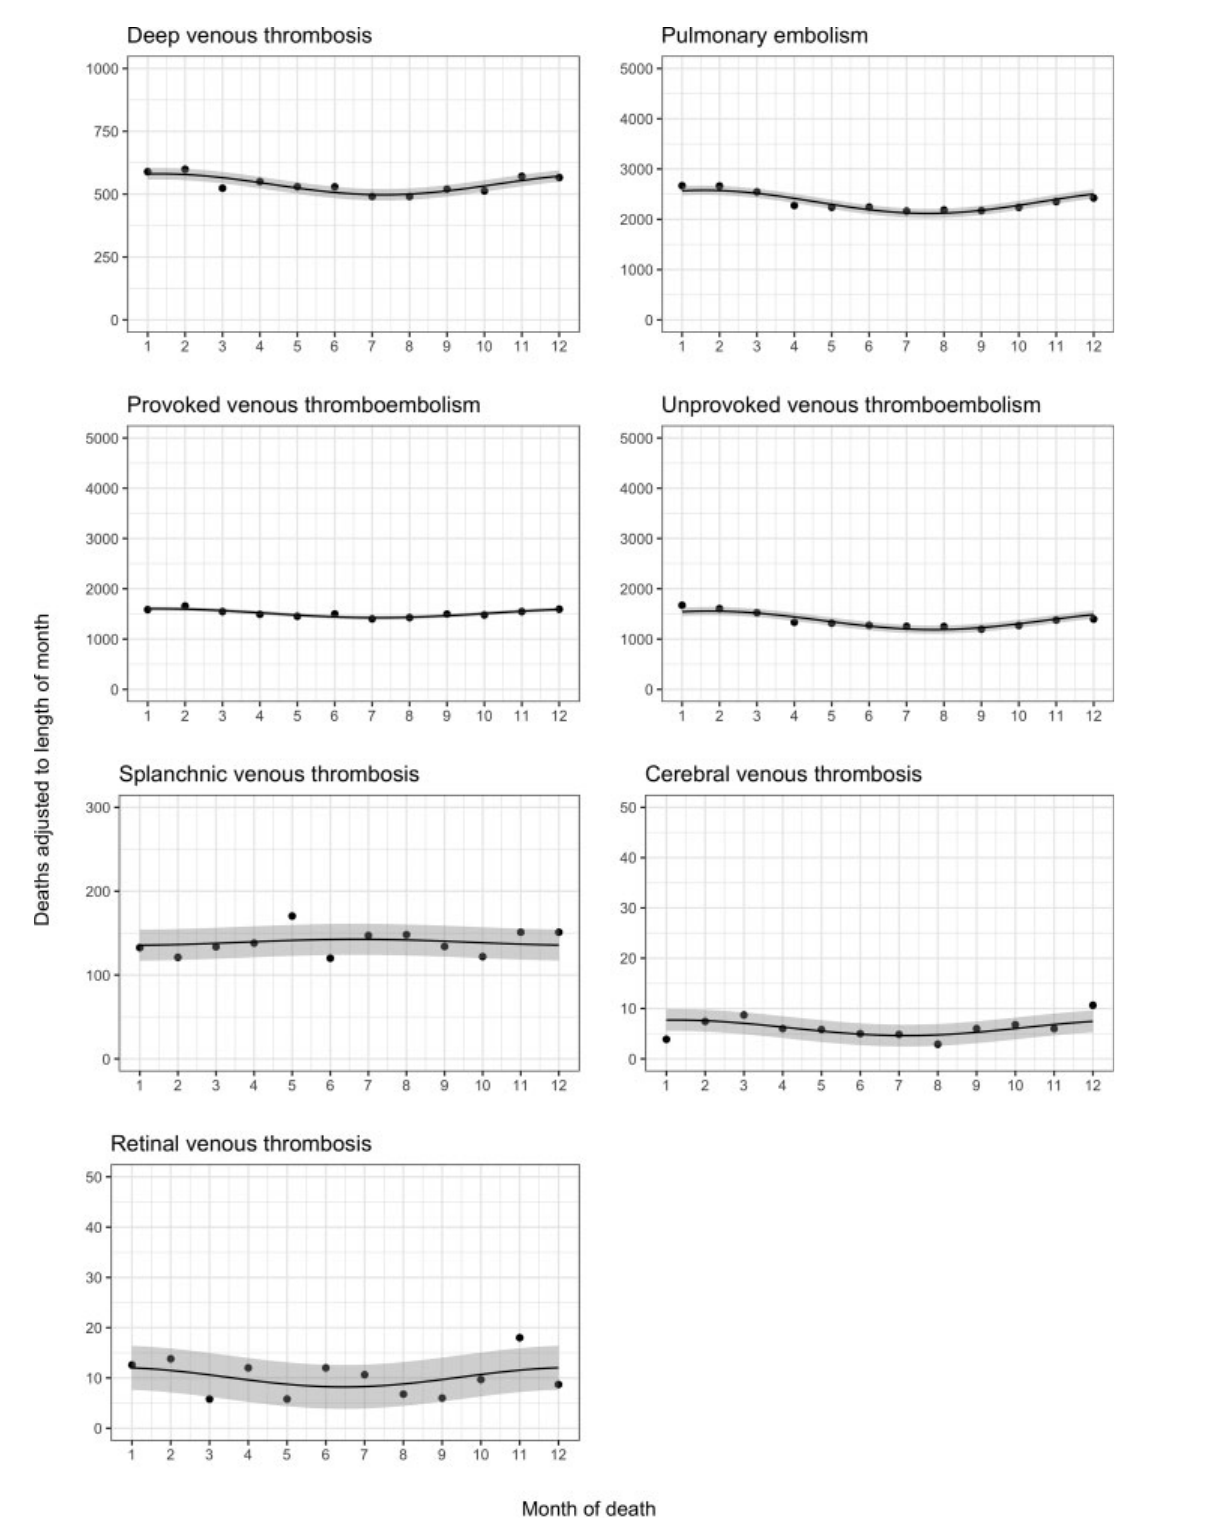
Fig. 2 Summarized deaths within each calendar month during 1977 – 2016 (within 90 days following deep vein thrombosis, pulmonary embolism, provoked venous thromboembolism, unprovoked venous thromboembolism, and splanchnic vein thrombosis) and 1994 – 2016 (within 90 days following cerebral vein thrombosis and retinal vein thrombosis), adjusted for the length of month with a fi tted sine curve and 95% con fi dence